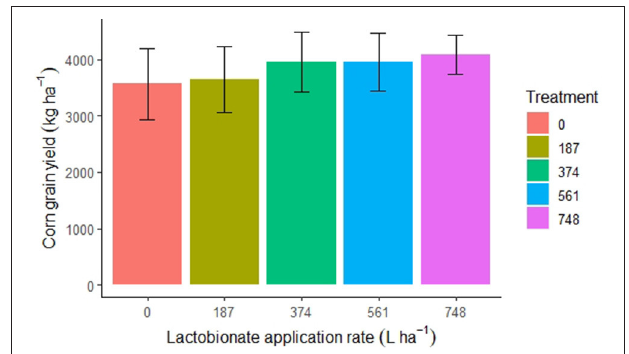
FIGURE 5 | Effect of lactobionate application on corn grain